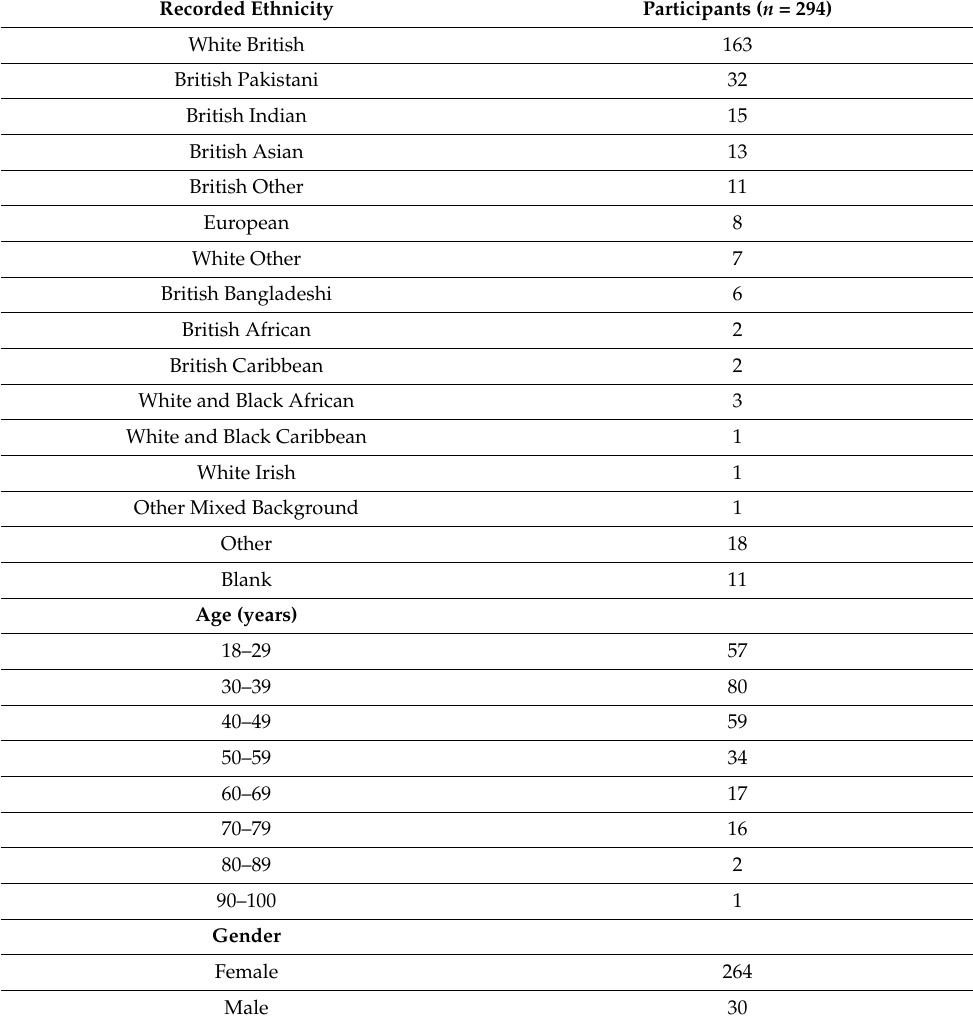
Table 1. Profile of participants ( n = 294) according to recorded ethnicity, age and gender. Recorded